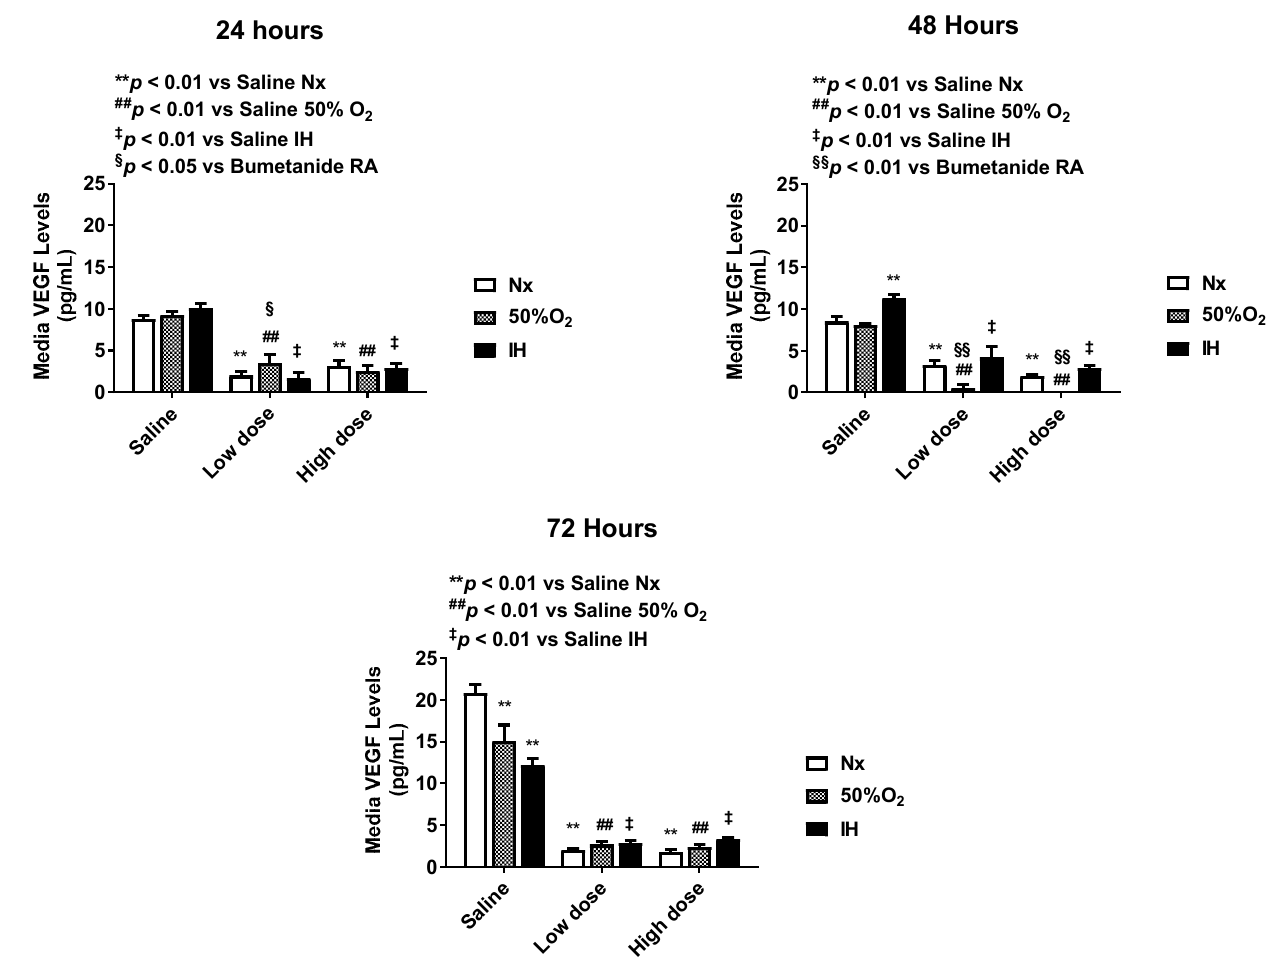
Figure 3. Dose-response effect of bumetanide on VEGF levels in the media from cultured human microvascular retinal endothelial cells (HMRECs) exposed to normoxia (white bar), hyperoxia (50% O 2 , shaded bar), or intermittent hypoxia (IH, black bar) for 24, 48, or 72 h. Data were analyzed using two-way ANOVA with Dunnett’s post hoc test. Data are mean ± SEM (8 samples/group). ** p < 0.01 versus saline RA; ## p < 0.01 versus saline 50% O 2 ; ‡ p < 0.01 vs. saline IH; and § p < 0.05, §§ p < 0.01 versus bumetanide treatment in RA.